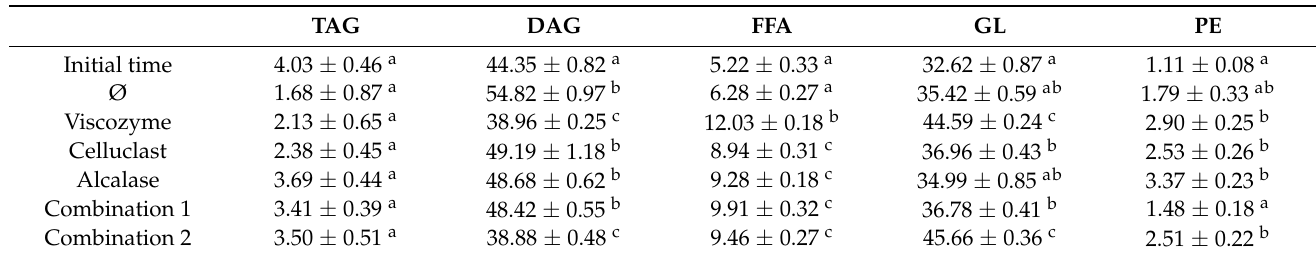
Table 1. Lipid classes distribution in different extracts obtained under traditional lipid extraction with the ultrasound- assisted enzymatic pretreatment at 6 h and analyzed by HPLC–ELSD, where triacyclglycerol (TAG), diacylglycerol (DAG), free fatty acid (FFA), glycolipid (GL), and phosphatidylethanolamine (PE) content are shown.